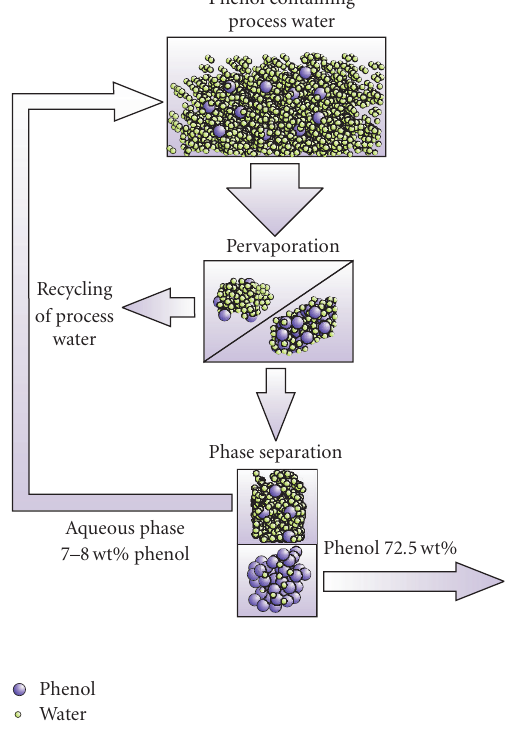
Figure 1: Process scheme for the removal of phenol from process